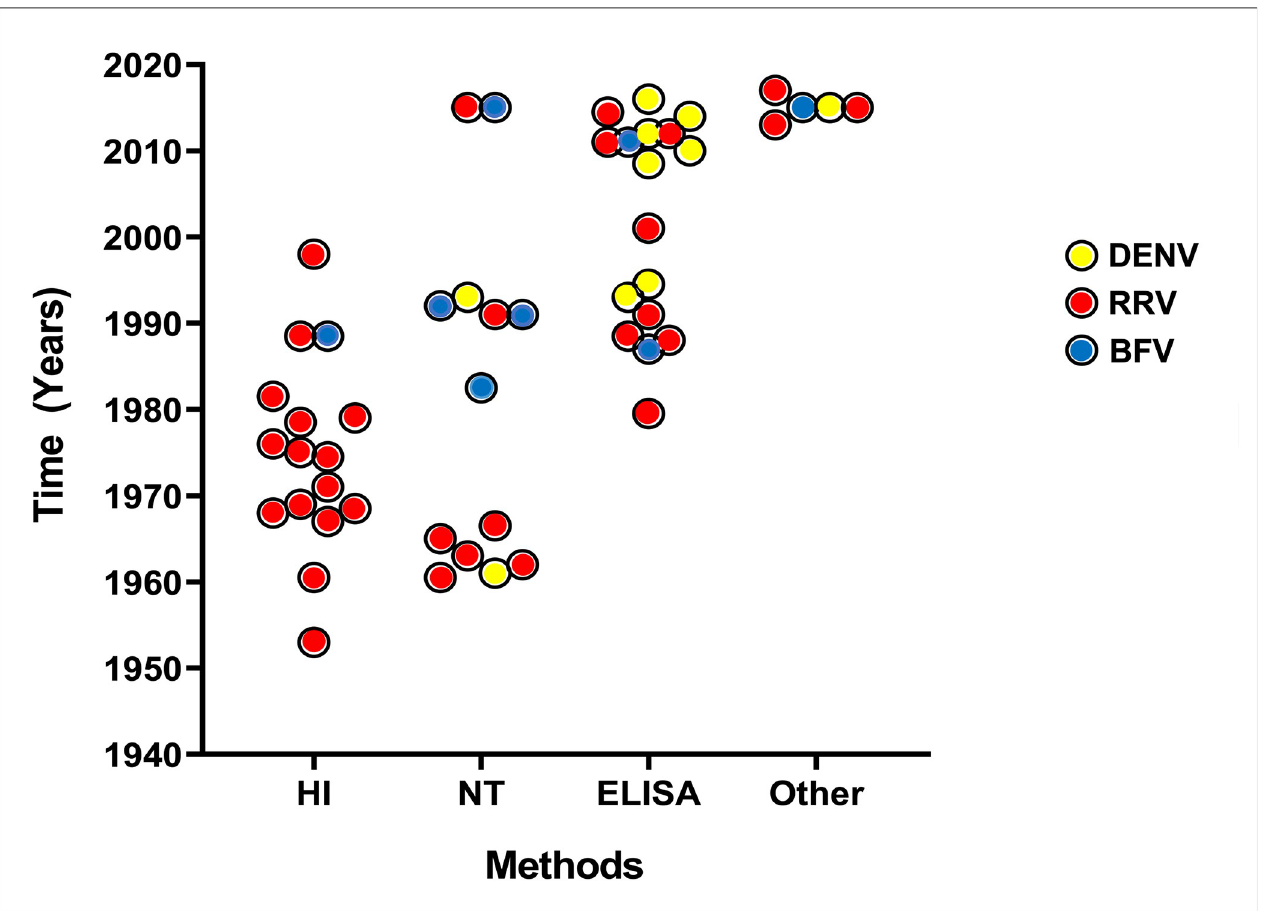
respectively, using the HI, NT, ELISA, and other immune assays. As shown in the figure, more HI and NT were applied in testing before the year 2000 and more ELISA tests were applied after 2000, with a statistically significant association between the serology method and time determined for DENV and